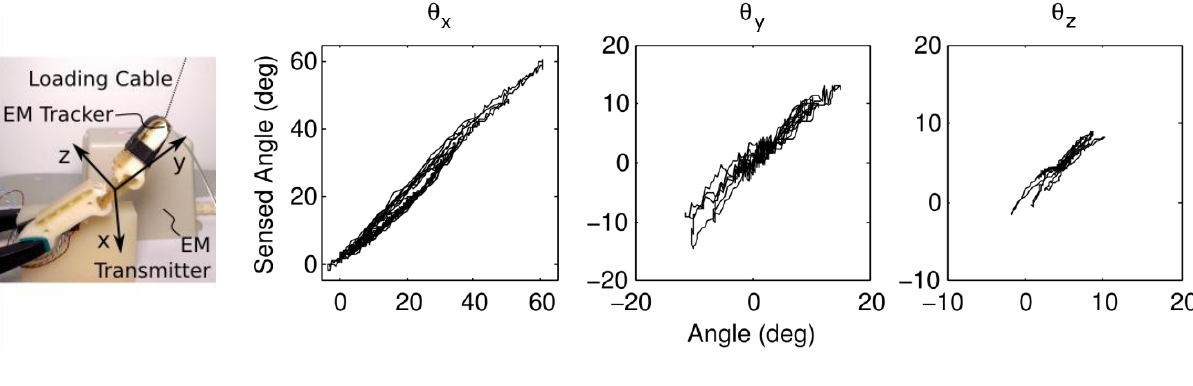
Table 1. Joint sensor